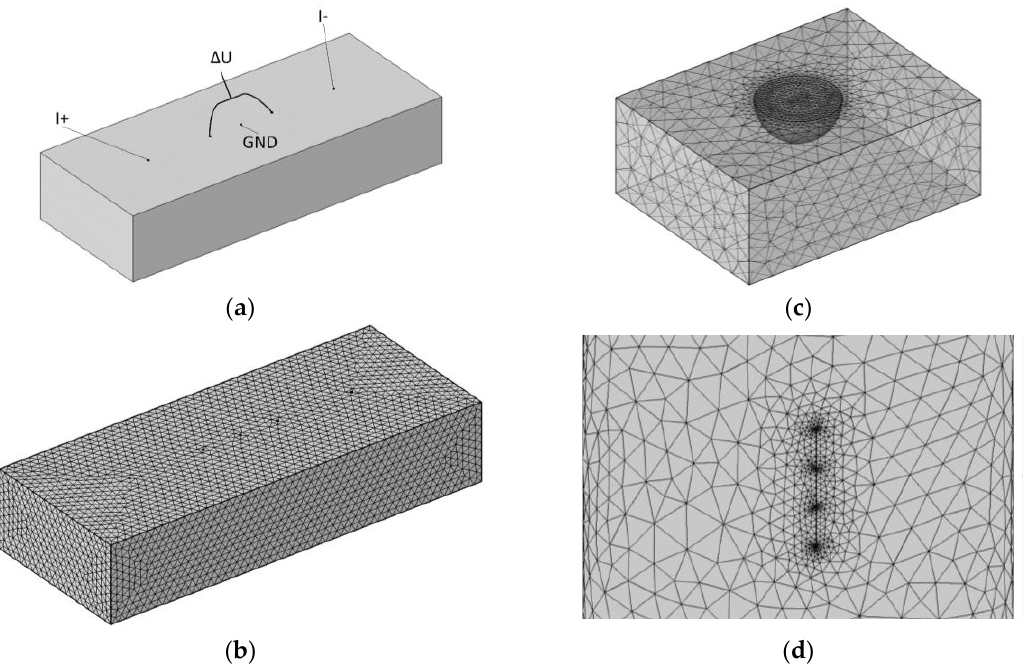
Figure A2. Various dividing models for the computational grid: ( a ) solid model; ( b ) global division; ( c ) local refinement; ( d ) uniformly increasing division.